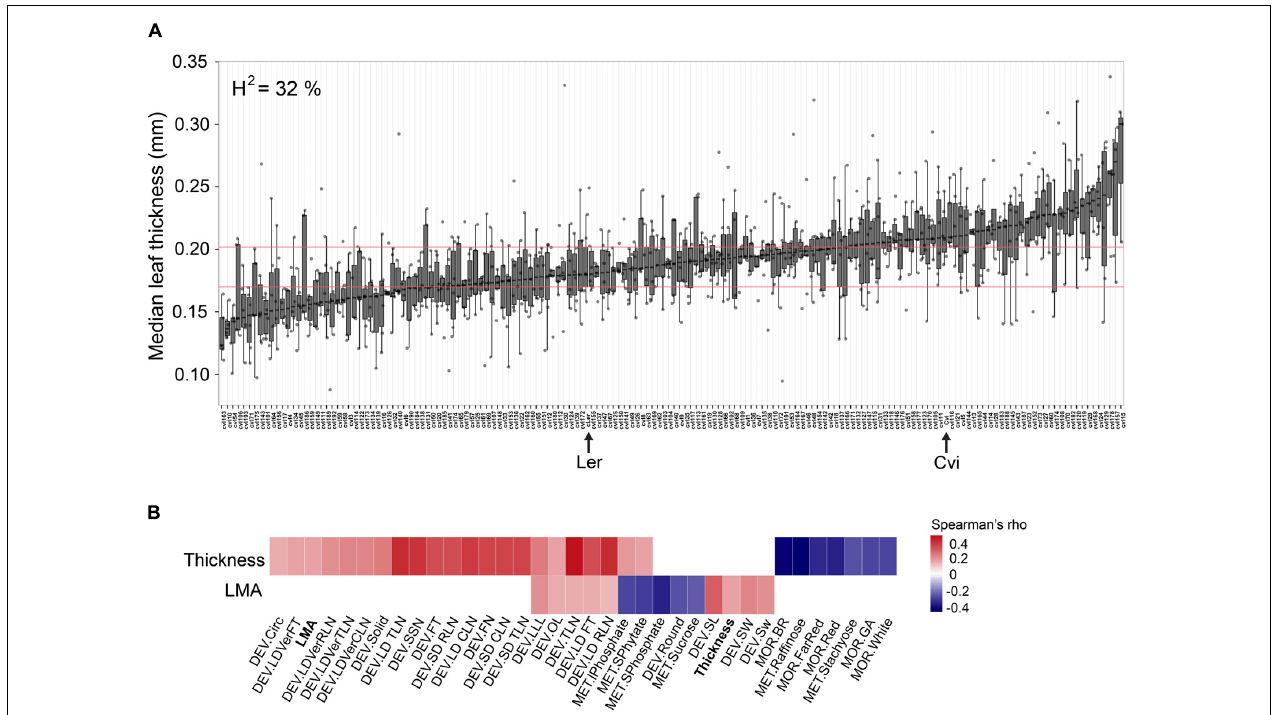
FIGURE 2 | (A) Median leaf thickness across the RIL panel. The Ler and Cvi parents are marked with arrows. Horizontal red lines demarcate the 25th to 75th leaf thickness percentile interval for Ler. Heritability for this trait is 32%. (B) Significant trait correlations (Spearman’s rho) between leaf thickness (Thickness) or LMA and a suite of other traits across the Ler × Cvi RIL panel ( q < 0.05). Traits are grouped by type: DEV, developmental; MET, metabolite; MOR, morphological ( Supplementary Datasets S1 , S2 ). Circ and Solid refer to lead shape; RLN, CLN, and TLN refer to rosette, cauline, and total leaf number, respectively; LD and SD, long and short days; Ver, vernalization; FT, flowering time; SSN, side shoot number; FN, flower number; LLL, longest leaf length; OL, ovary length; SL, seed length; SW, seed weight; BR, GA, FarRed, Red, and White, reflect hypocotyl length after treatment with brassinazole; GA, or in far red, red, or white, light